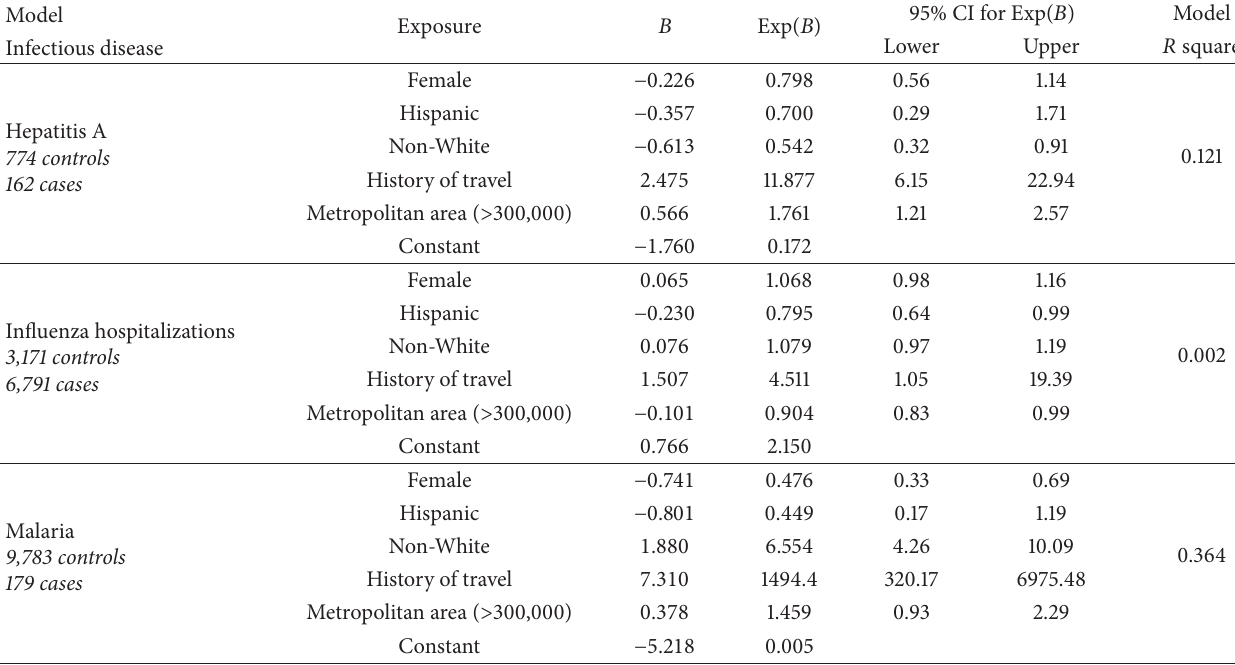
Table 2: Logistic regression of all confirmed cases of malaria, hepatitis A, and influenza. Hospitalizations in the cohort of the total population of Ohio from 2010 through 2014 (suspect and probable reports were excluded from the cases). Model Model Infectious disease 𝑅